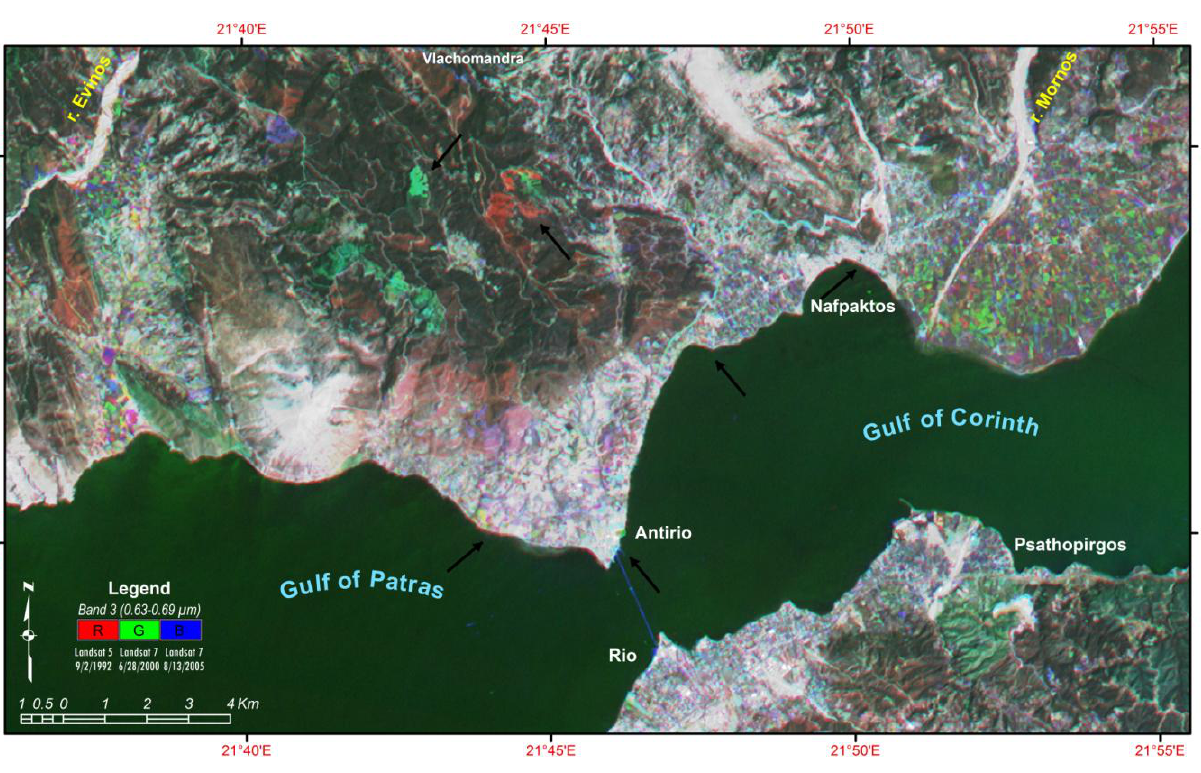
Figure 4. Multi-temporal pseudo-color image produced from layer stacking of Landsat satellite data (Band 3, 0.63 to 0.69 μm) with three different acquisition dates. High contrast spots in the forested area reveal changes in reflectance due to human activity or forest fires. The time at which the reflectance changed can be estimated by the colors on the image, as described in the text (see black